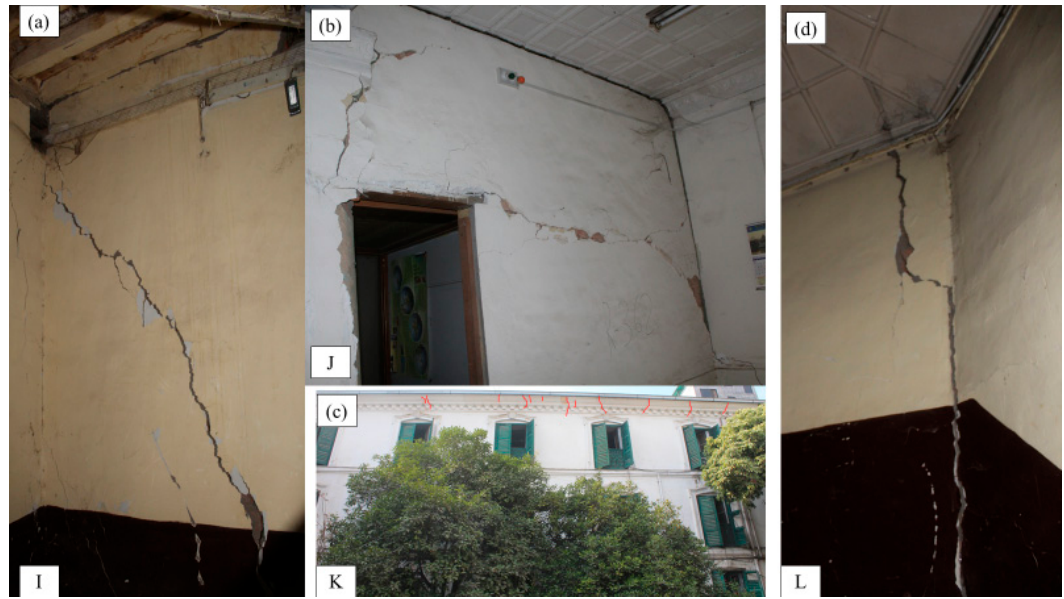
Figure 5. Local damages in the monument ( a ) diagonal crack on the third-floor wall, ( b ) horizontal and vertical cracks beside the opening, ( c ) exterior wall damage at the top floor, ( d ) corner damage (uppercase indications at the bottom of the structures are the location indications as shown in Figure 2).